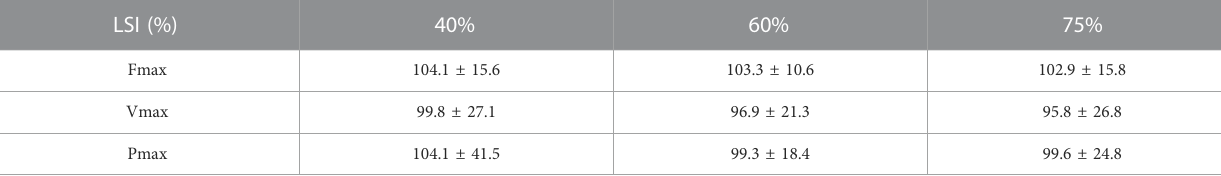
TABLE 2 Values of LSI for the mechanical variables analysed and results of comparison between the different load conditions. LSI (%)